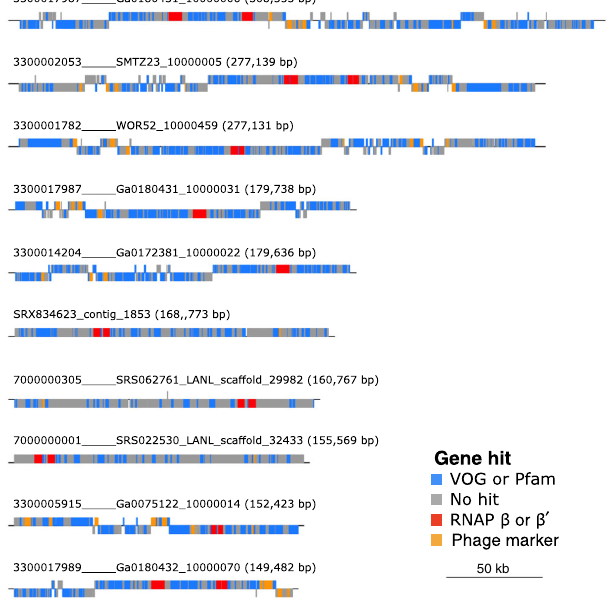
Fig. 1 Genome plots of the ORFs of the ten longest mReC contigs. Above each plot is the contig name with its length in parentheses. Color corresponds to gene or database. Phage marker genes include baseplate wedge, portal proteins, capsids, terminases, and tail proteins. Scale bar corresponds to genome length of 50